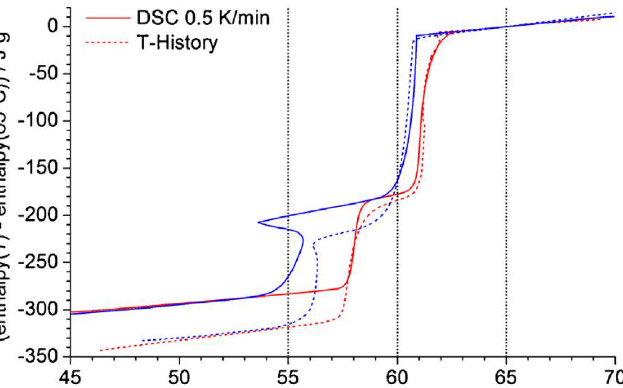
Figure 13. Baseline correction: ( a ) base-line construction (zeroline); ( b ) Effect of baseline correction on the enthalpy curve (personal data).